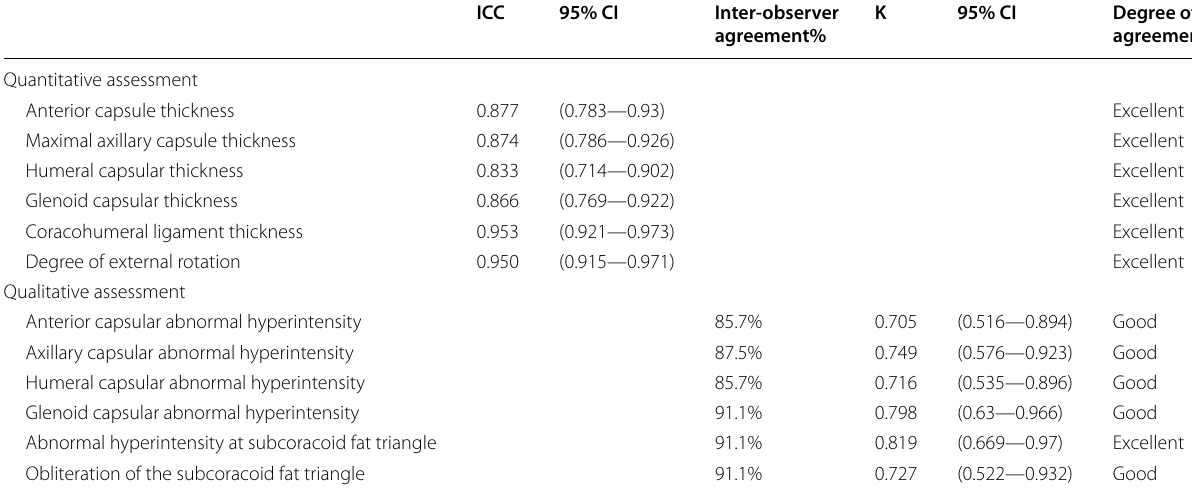
Table 5 Reliability measures for both qualitative & quantitative assessments (inter-rater